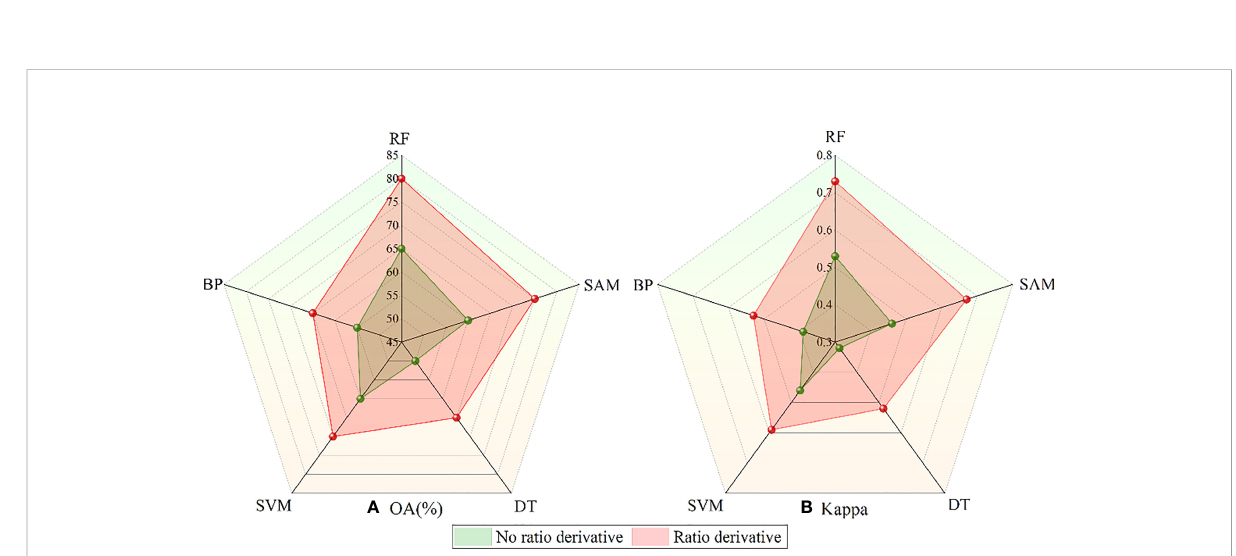
FIGURE 13 Accuracy comparison of different algorithms before and after processing by the DRS algorithm. (A) Comparison results of OA. (B) Comparison results of Kappa.